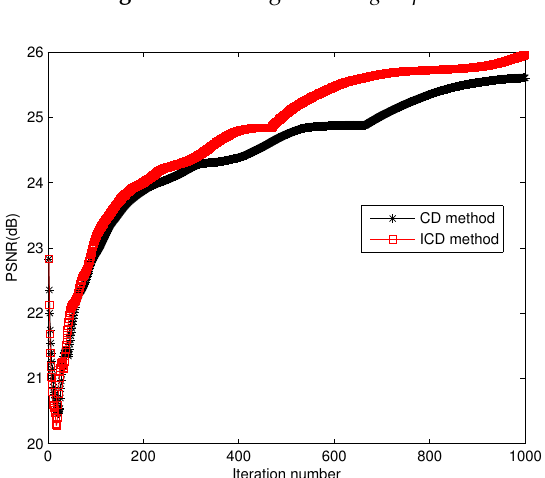
Figure 9. Running time for group1 .